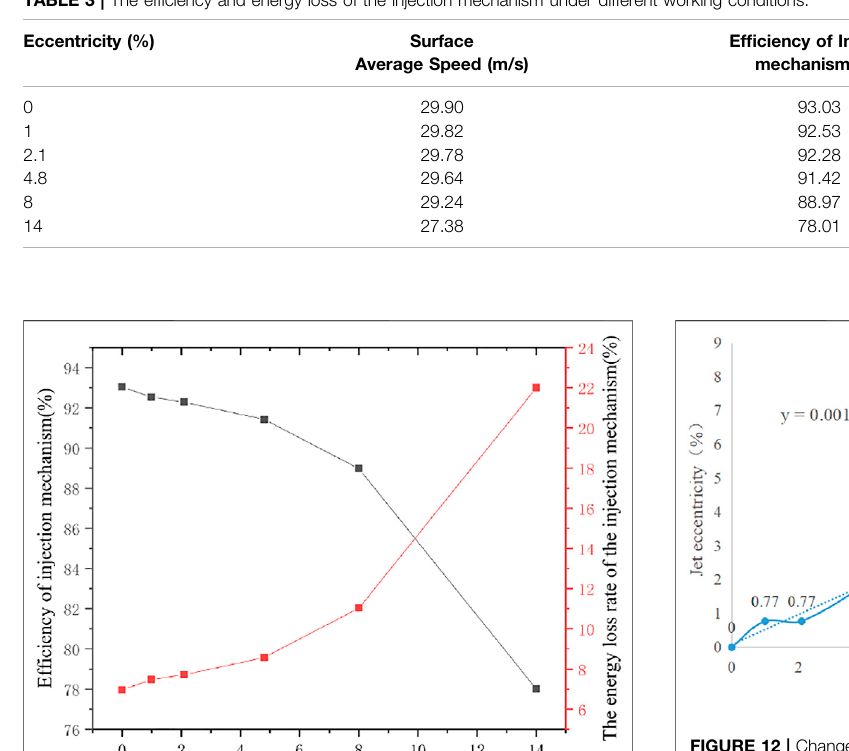
FIGURE 12 | Change of jet